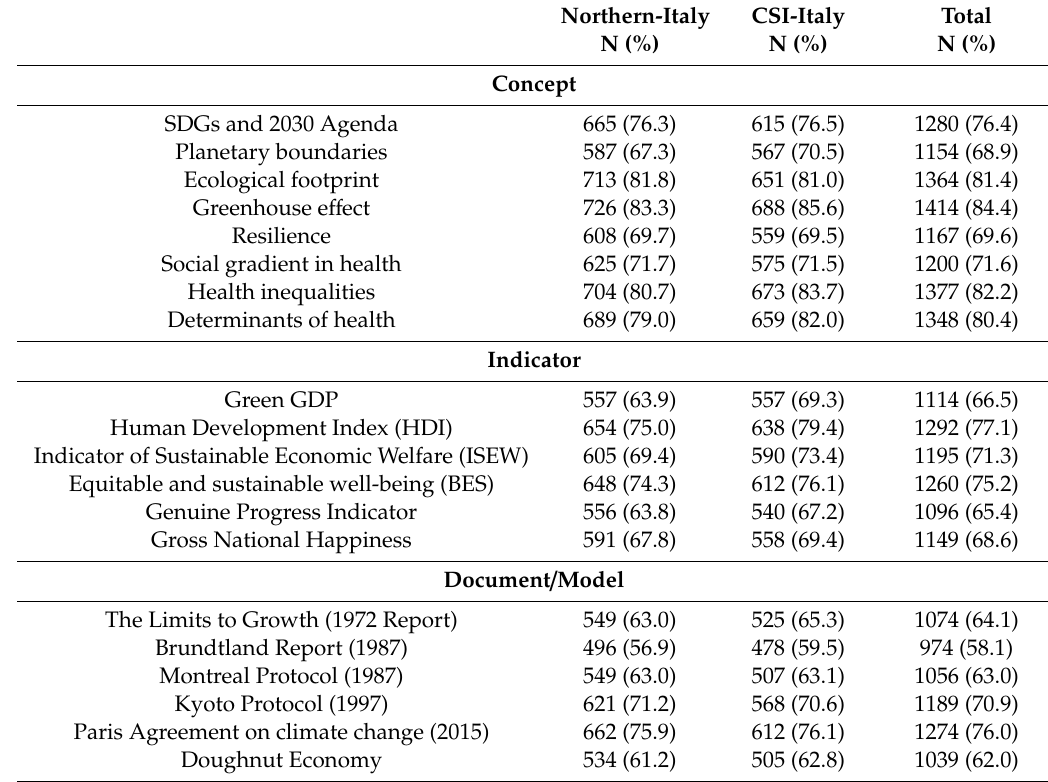
Table 3. Number and percentage of respondents declaring learning expectations for each surveyed item; results reported for Northern and